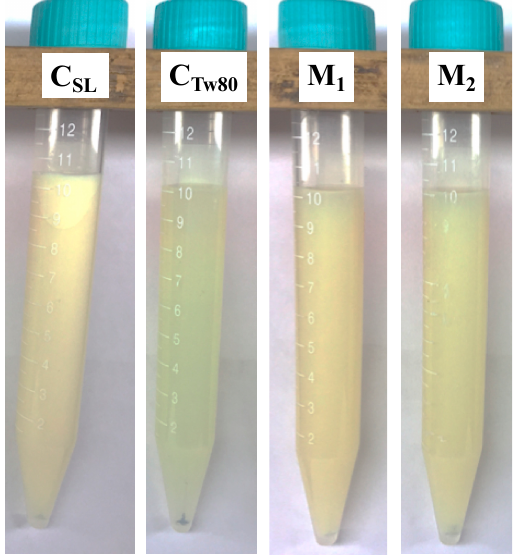
Figure 2. Physical stability of nanoemulsions elaborated with di ff erent emulsifier mixtures and control samples after the centrifugation process at 2400 × g for 15 min. M 1 : mixture 1 (soy lecithin—SL, Tween 80—Tw80 and sodium caseinate—CasCa), M 2 : mixture 2 (soy lecithin—SL, Tween 80—Tw80